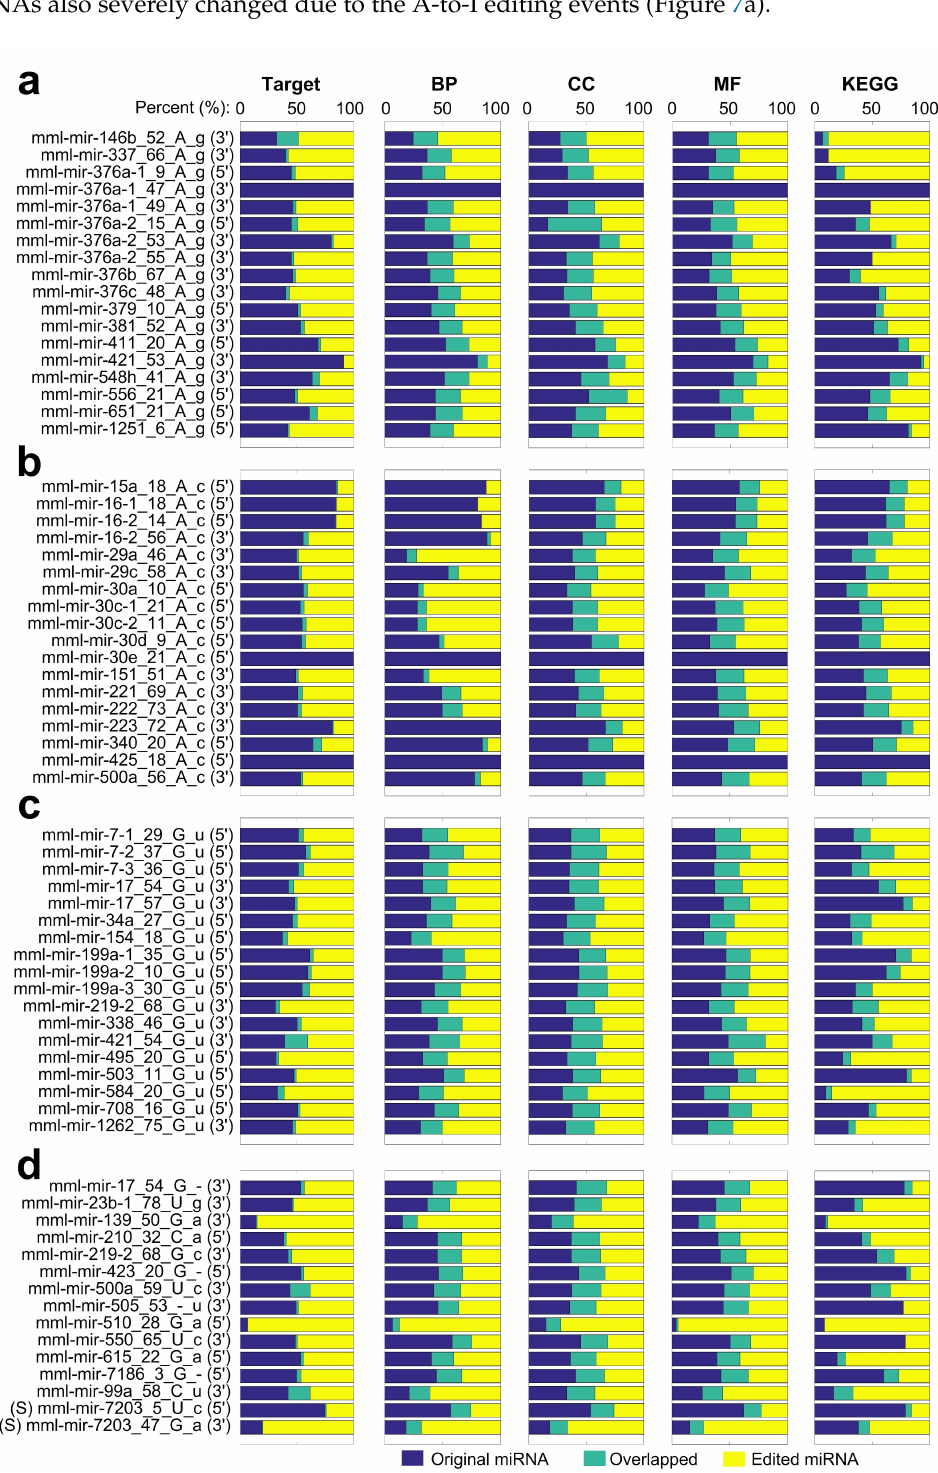
Figure 7. The comparisons of targets, enriched GO terms and KEGG pathways for 69 original and edited/mutated miRNAs whose M/E sites locate in seed regions. Each line started with the MiRME ID